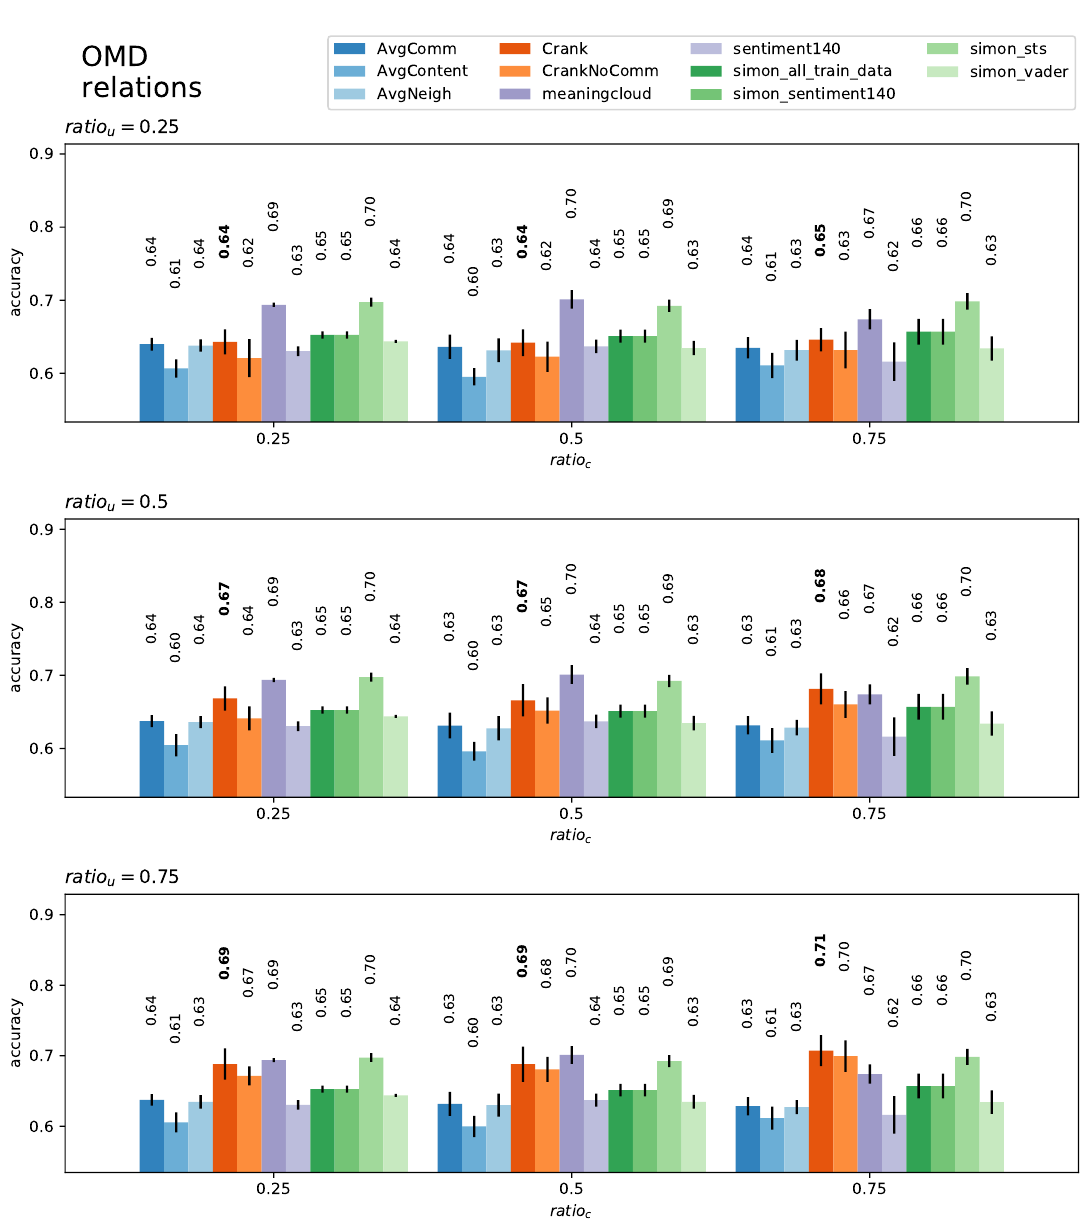
Figure 4. Content-level classification mean accuracy and standard deviation in the OMD dataset for each model at each level of certainty ( ratio u and ratio c )